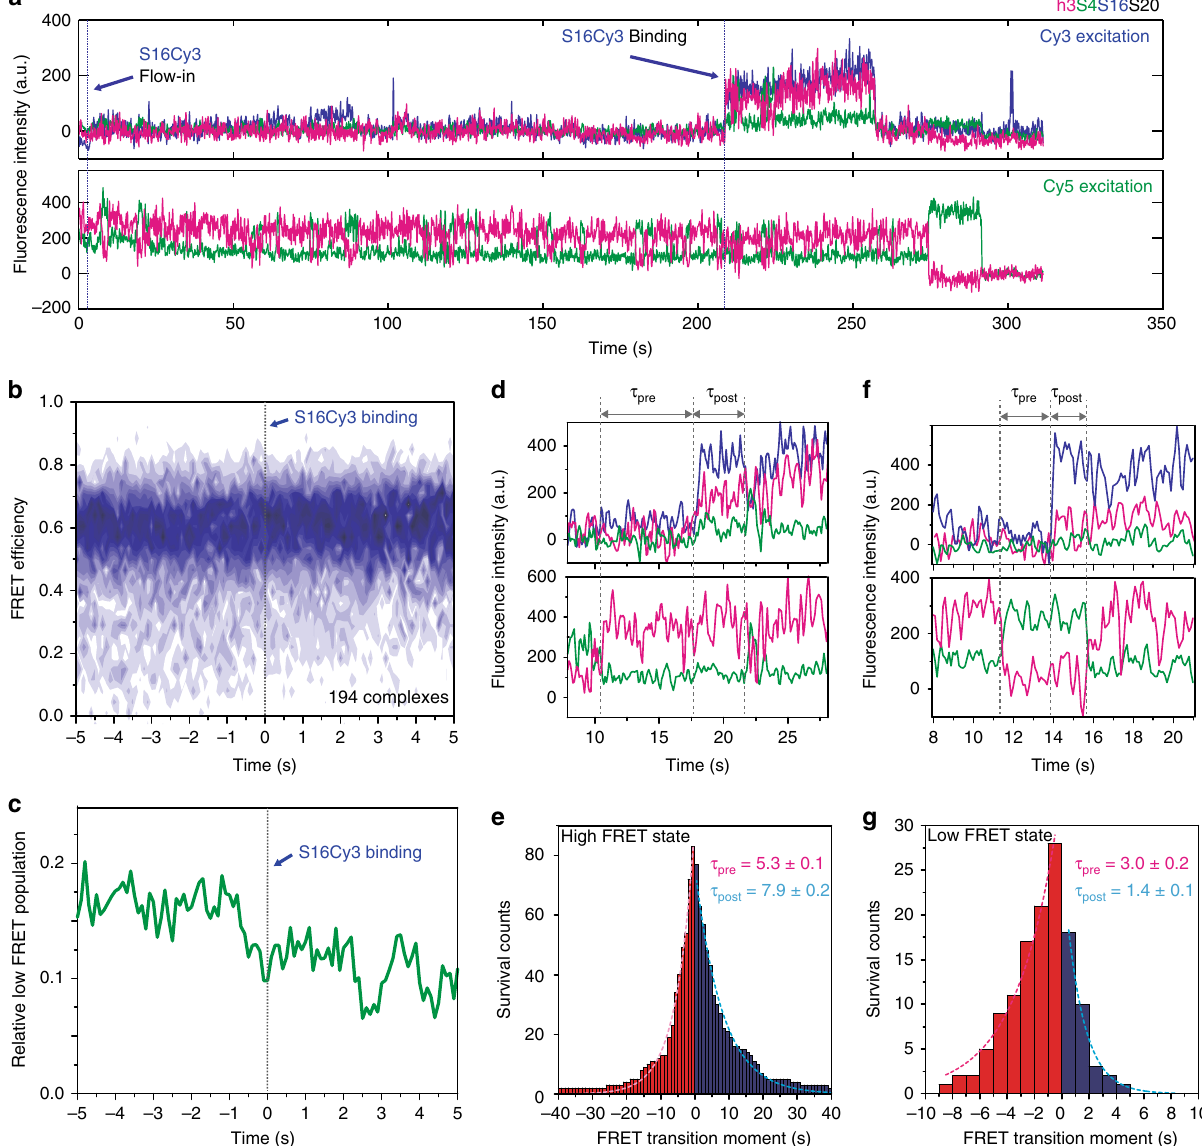
Fig. 4 S16 indirectly induces the folding of the RNA. a Real-time binding of S16 to RNA – S4 – S20 complexes. S16-Cy3 was fl owed into slide chambers containing immobilized RNA h3-Cy7 · S4-Cy5 · S20 complexes. Three-color fl uorescence traces with alternating Cy3 and Cy5 excitation demonstrate successful S16 binding following several trials, as indicated by the increase in Cy3 signal (top). 16S h3 fl uctuates before and after S16 binding (bottom). b Time-dependent population map of S4-h3 FRET was obtained from 194 traces that are post-synchronized at the moment of S16 binding (dashed line). c Low FRET population ( E < 0.35) from the map in b gradually decreases before and after S16 binding, demonstrating the preference of S16 for binding the complex in the high FRET state and its additional stabilization of the high-FRET complex. d – g Lifetimes of the high and low FRET states of h3 before and after the moment of S16 binding were compared. d The lifetimes of the high FRET state were calculated from the interval between S16 binding and the low- to-high FRET transition prior to it ( τ pre ) or the high-to-low FRET transition following it ( τ post ). e The average lifetime of the high FRET state slightly increased upon S16 binding (83 traces). f , g Analysis as in d , e showing that the lifetime of the low FRET state decreased signi fi cantly after S16 binding (28 S16 (S4 only or without proteins), h12 separates from h3 To experimentally probe how S16 binding alters the fl exibility (toward the h12 ′ position in Fig. 5a) and allows h3 to move of the 5 ′ domain RNA, we used SHAPE chemical modi fi cation of away from the 5WJ and S4, leading to the non-native low FRET the ribose 2 ′ OH to compare the fl exibility of the RNA backbone state (Fig. 5b). Thus, our combined simulations and smFRET in the presence and absence of S16 (Supplementary Fig. 5). results suggest that S16 can bind the 5 ′ domain in both the Nucleotides in 16S h7 and h11, which form part of the S17 fl ipped and docked h3 conformations. Once bound, S16 favors binding domain, were more protected from SHAPE modi fi cation the native h3-h12 conformation by extending the lifetime of the in reactions with proteins S4, S17, S20 and S16, relative to h3 docked state and shortening the lifetime of the non-native reactions with S4, S17, and S20 only ( blue ; Fig. 5c) 18 . This fl ipped state. increased protection is consistent with more stable interaction